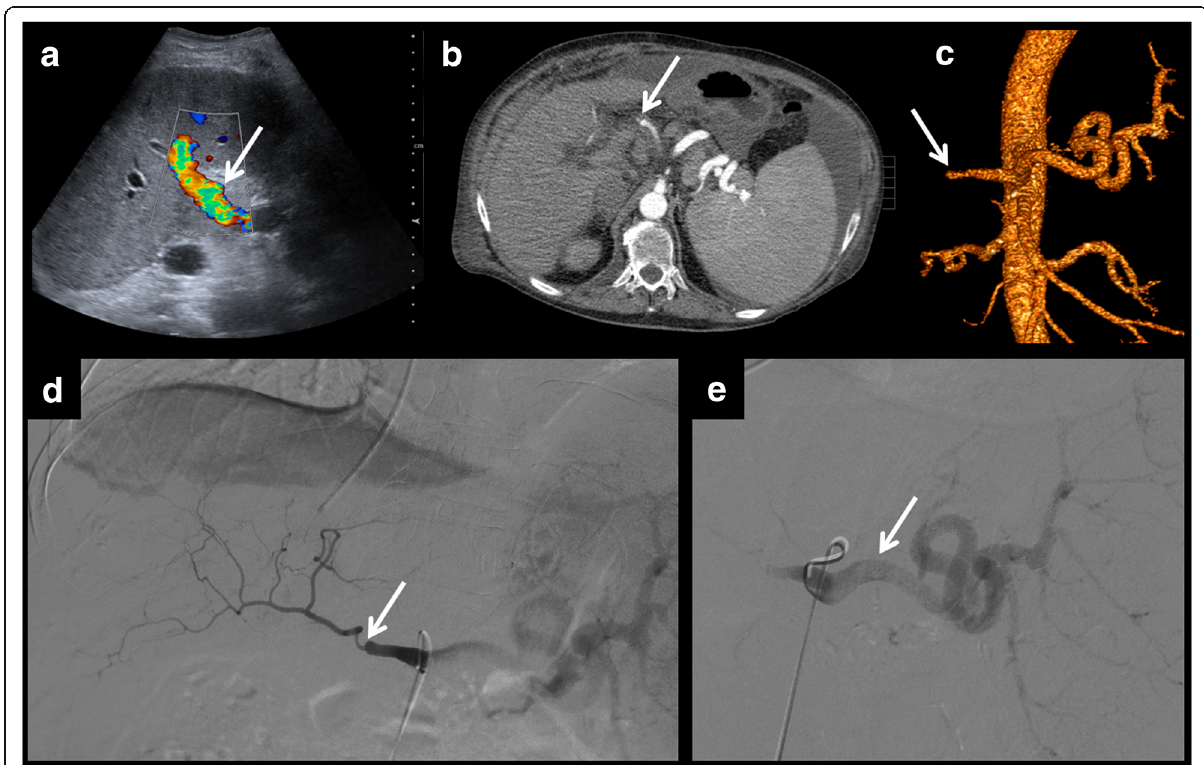
Fig. 6 Hepatic artery stenosis leading to splenic artery steal syndrome. Postsurgical US shows a turbulent flow of the hepatic vein. The hepatic artery cannot be clearly identified ( a ). An arterial phase CT is performed, showing severe focal stenosis of the hepatic artery and filiform enhancement of its branches ( b , c ). The increased size of the splenic artery should also be noted. Increased splenic artery blood flow explains the increased turbulent portal flow. Angiography confirms both stenosis of the hepatic artery and the increased size of the splenic artery ( d , e ).